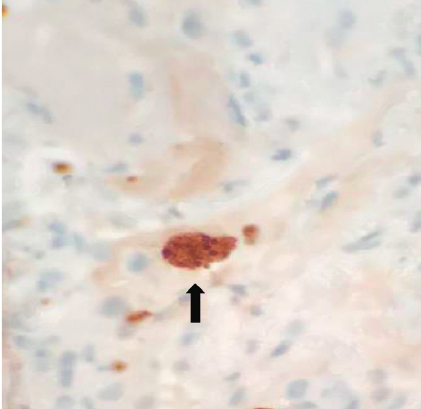
Figure 4: Toxoplasma immunohistochemical stain showed cyst- containing bradyzoites (arrow).